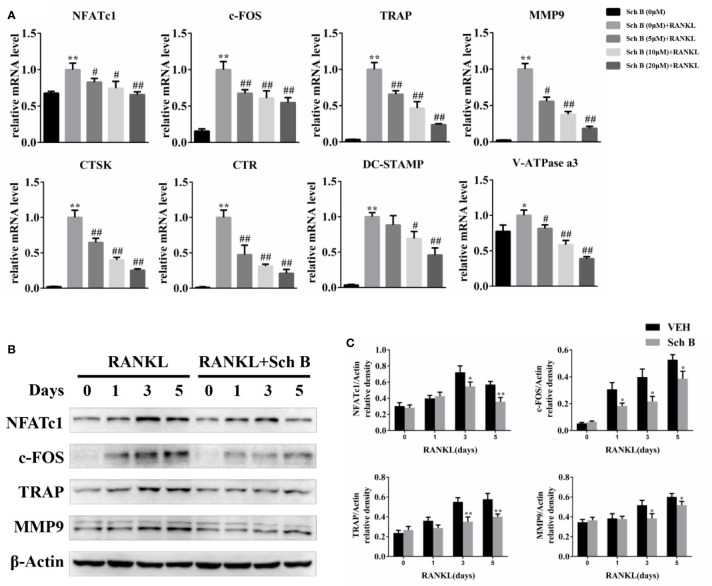
Schisandrin B downregulates osteoclast-related genes expression. (A) Bone marrow macrophages (BMMs) were treated with different concentrations of Schisandrin B (0, 5, 10, and 20 μM) in the presence of macrophage colony stimulating factor (M-CSF) and receptor activator of nuclear factor-κB ligand (RANKL) for 2 days. mRNA expression of osteoclast-related genes was measured by qPCR. (B, C) BMMs were cultured with or without 20μM Schisandrin B in the presence of M-CSF and RANKL for the indicated time periods. Protein expression of osteoclast-related genes was quantified using β-Actin as an internal control. The data were confirmed by three independent experiments and are expressed as means ± SD. *P < 0.05, **P < 0.01 versus the vehicle. #P < 0.05, ##P < 0.01 versus the Sch B (0 μM) + RANKL group.